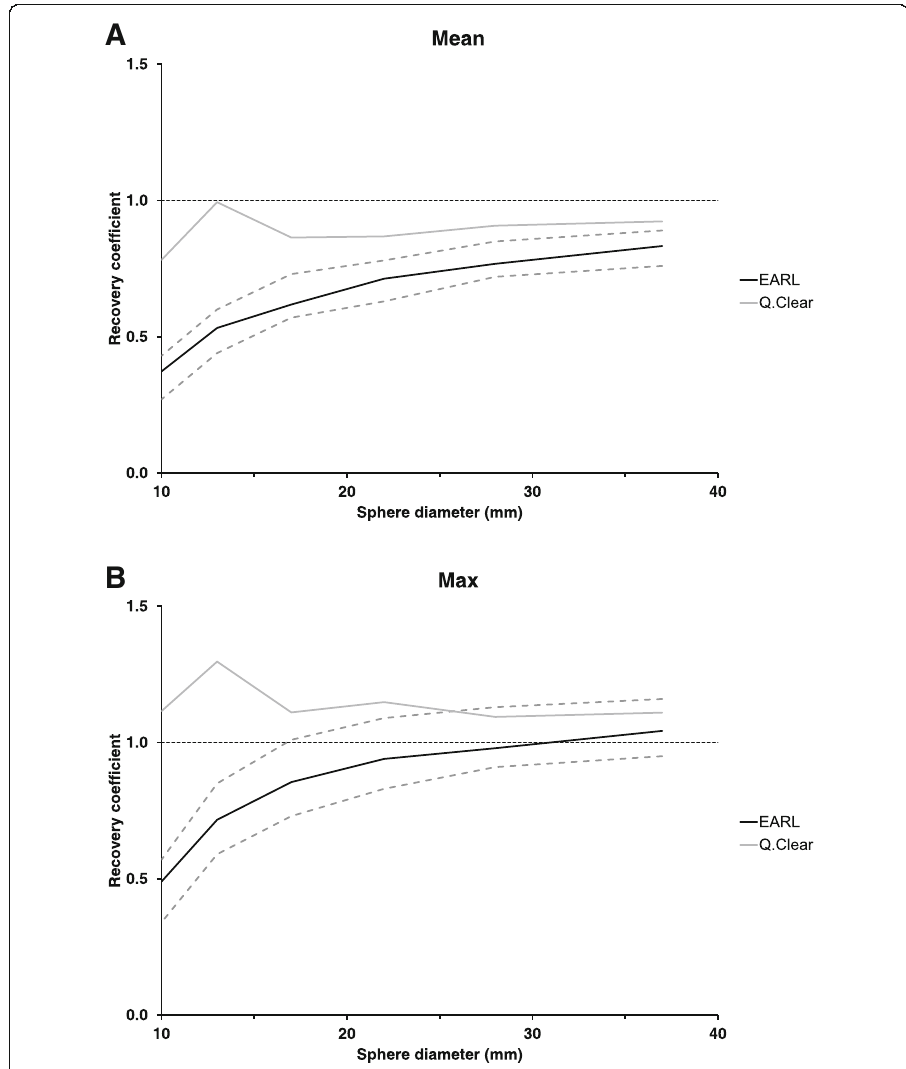
Fig. 1 NEMA phantom recovery coefficients for the mean ( a ) and maximum ( b ) pixel values (dashed lines: EARL accreditation minimum and maximum